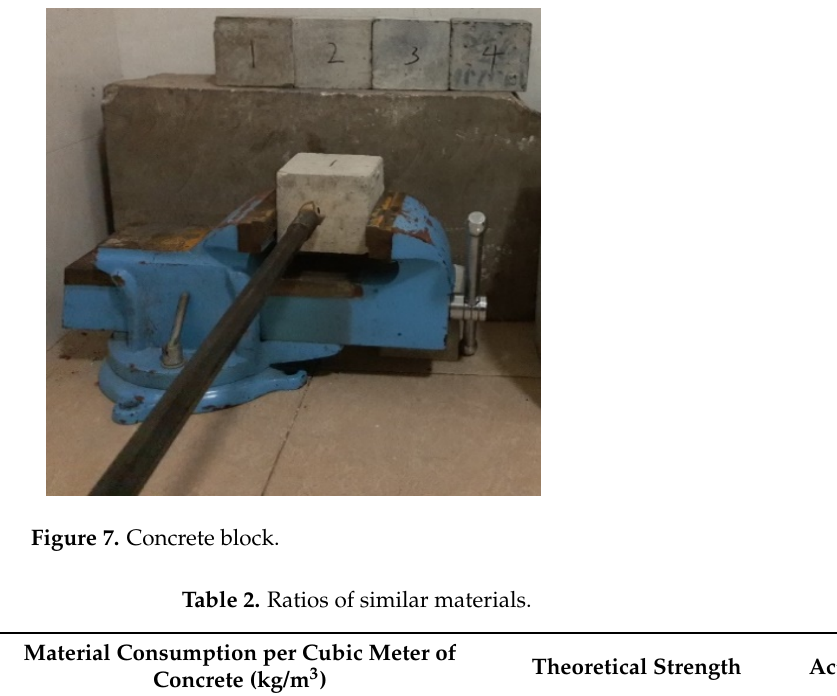
Table 2. Ratios of similar materials.